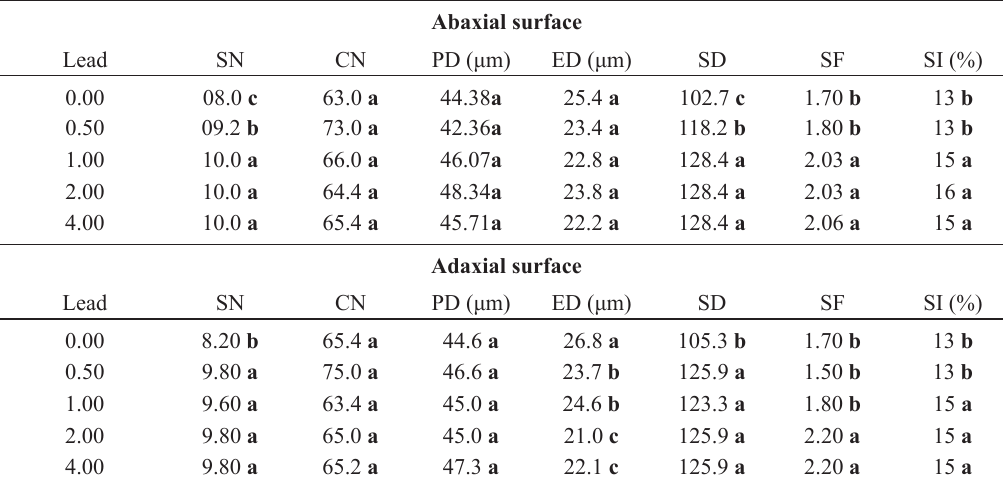
Means followed by same letters in columns did not differ by Scott-Knott test at P<0.05. SN = number of stomata by field; CN = number of regular epidermal cells by field; PD = stomatal polar diameter; ED = stomatal equatorial diameter; SD = stomatal density (stomata by mm 2 ); SF = stomatal functionality (PD/ED rate); SI = stomatal